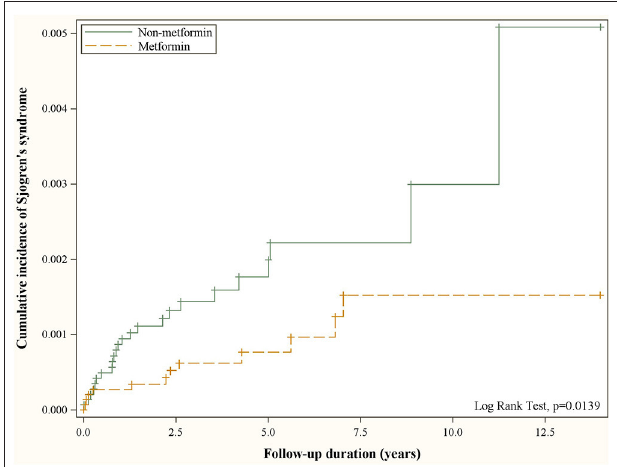
FIGURE 2 | Cumulative incidence of Sjögren’s syndrome in patients with and without metformin use obtained using the Kaplan–Meier method.